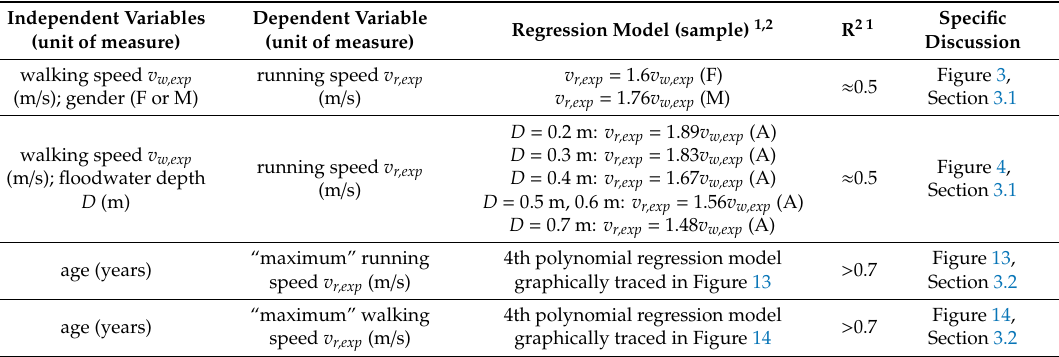
Table 1. Selected modelling approaches based on dimensional dependent variables.